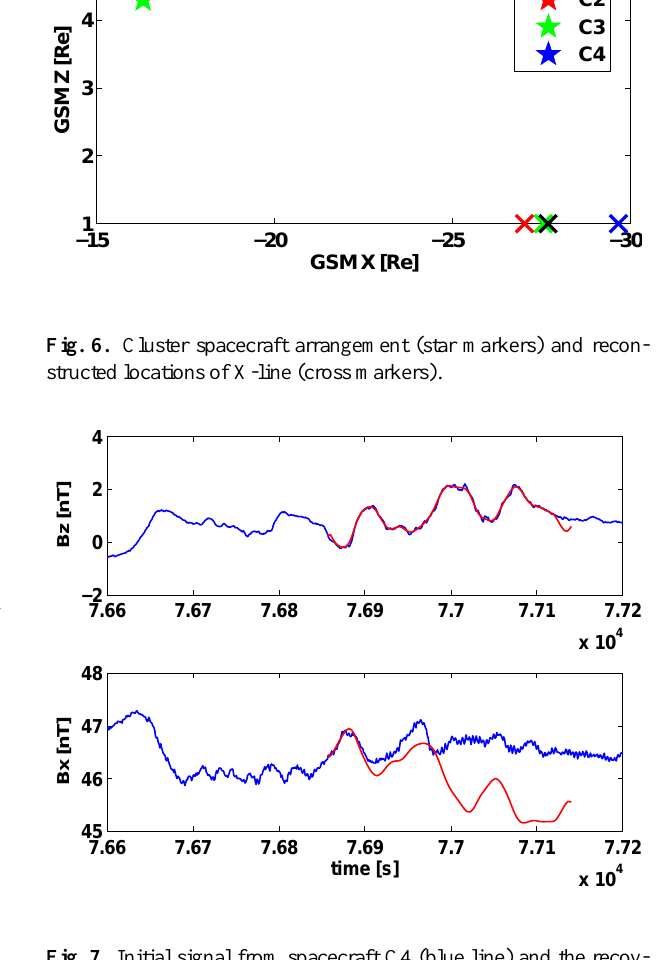
Fig. 7. Initial signal from spacecraft C4 (blue line) and the recov- ered signal (red